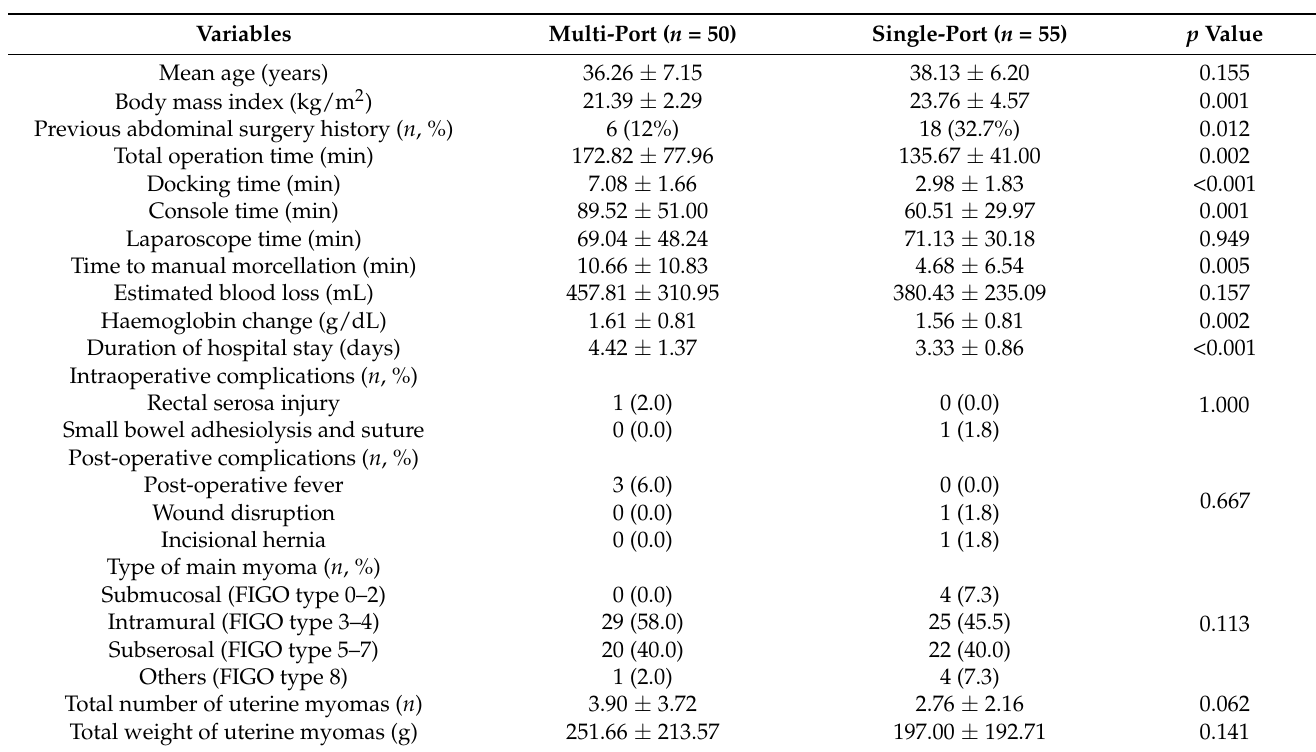
Table 1. Clinicopathologic characteristics and surgical outcomes of robot myomectomy before 1:1 propensity score matching.